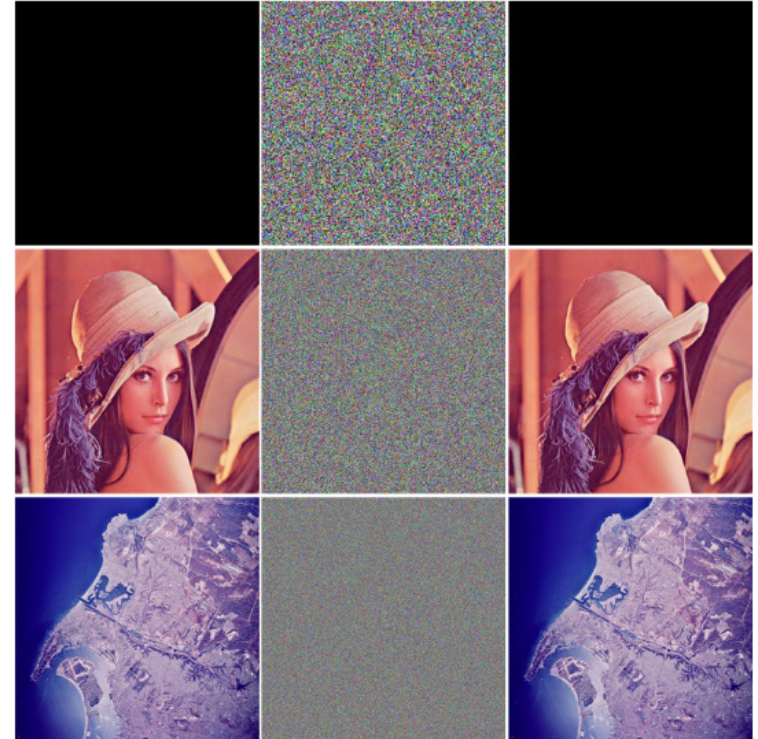
Figure 8. Encrypt and decode.